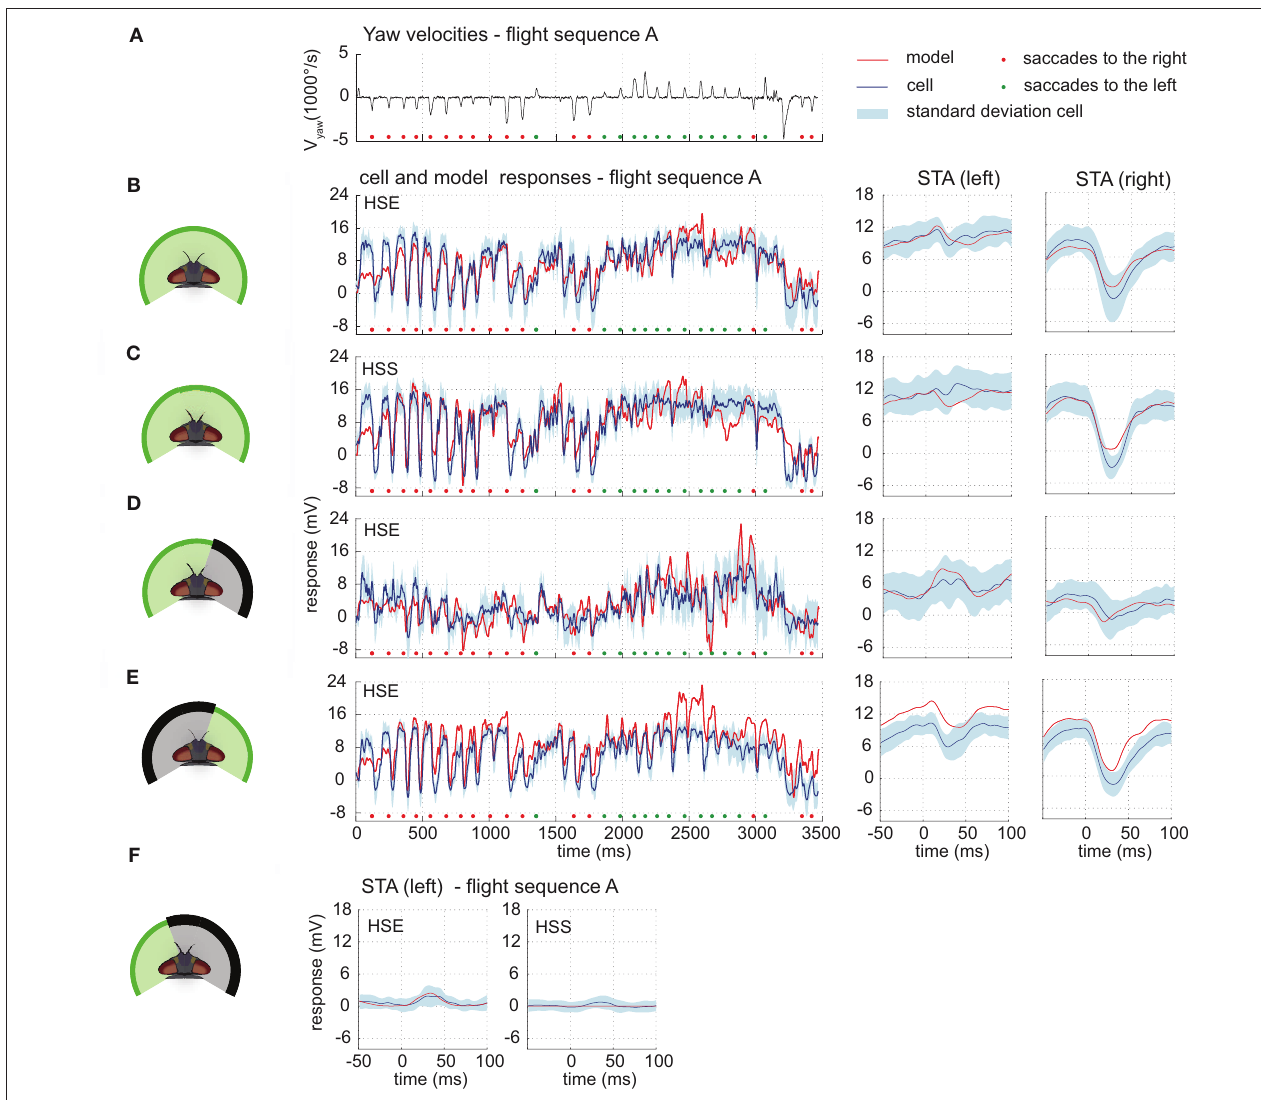
(D,e) Responses and STAs of the right HSE-cell (blue) and model (red) to flight sequence A and different parts of the visual field stimulated as depicted at the left of each row. (F) STAs of the right HSE- (left) and the right HSS-cell (right) and of the corresponding models (red) for saccades to the left while the left part of the visual field is stimulated by flight sequence A. All color and sign codes as in Figure 4